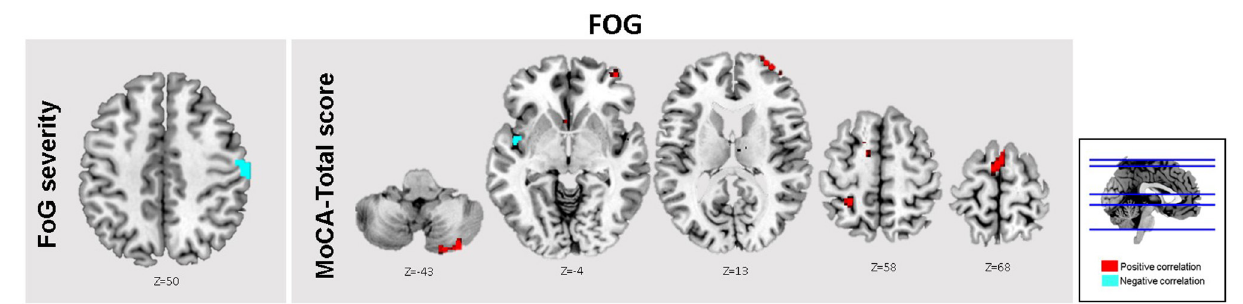
FIGURE 3 | Brain regions within the brainstem network showing significant associations between FC levels, and clinical scores. In the FOG group, the total MOCA scores were significantly associated with FC levels in the A ACC, SMA, L MFG, and bilateral cerebellar crus II (Red). Moreover, significant inverse associations between FOG severity scores and FC levels within the R PCG (Cyan). Results are reported at threshold p < 0.01- FWE c.